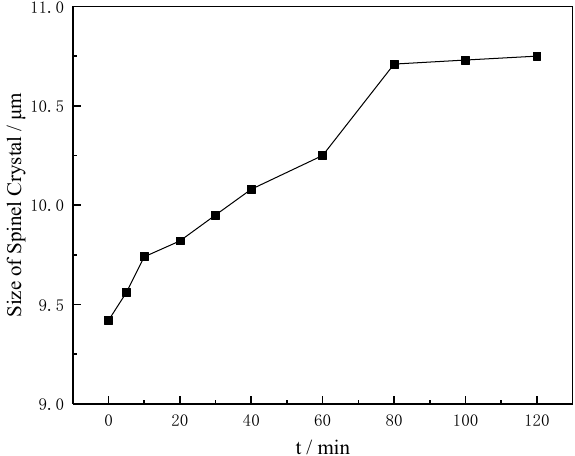
Figure 4. Effect of heat treatment time on the size of the spinel crystals at 1450 °C.